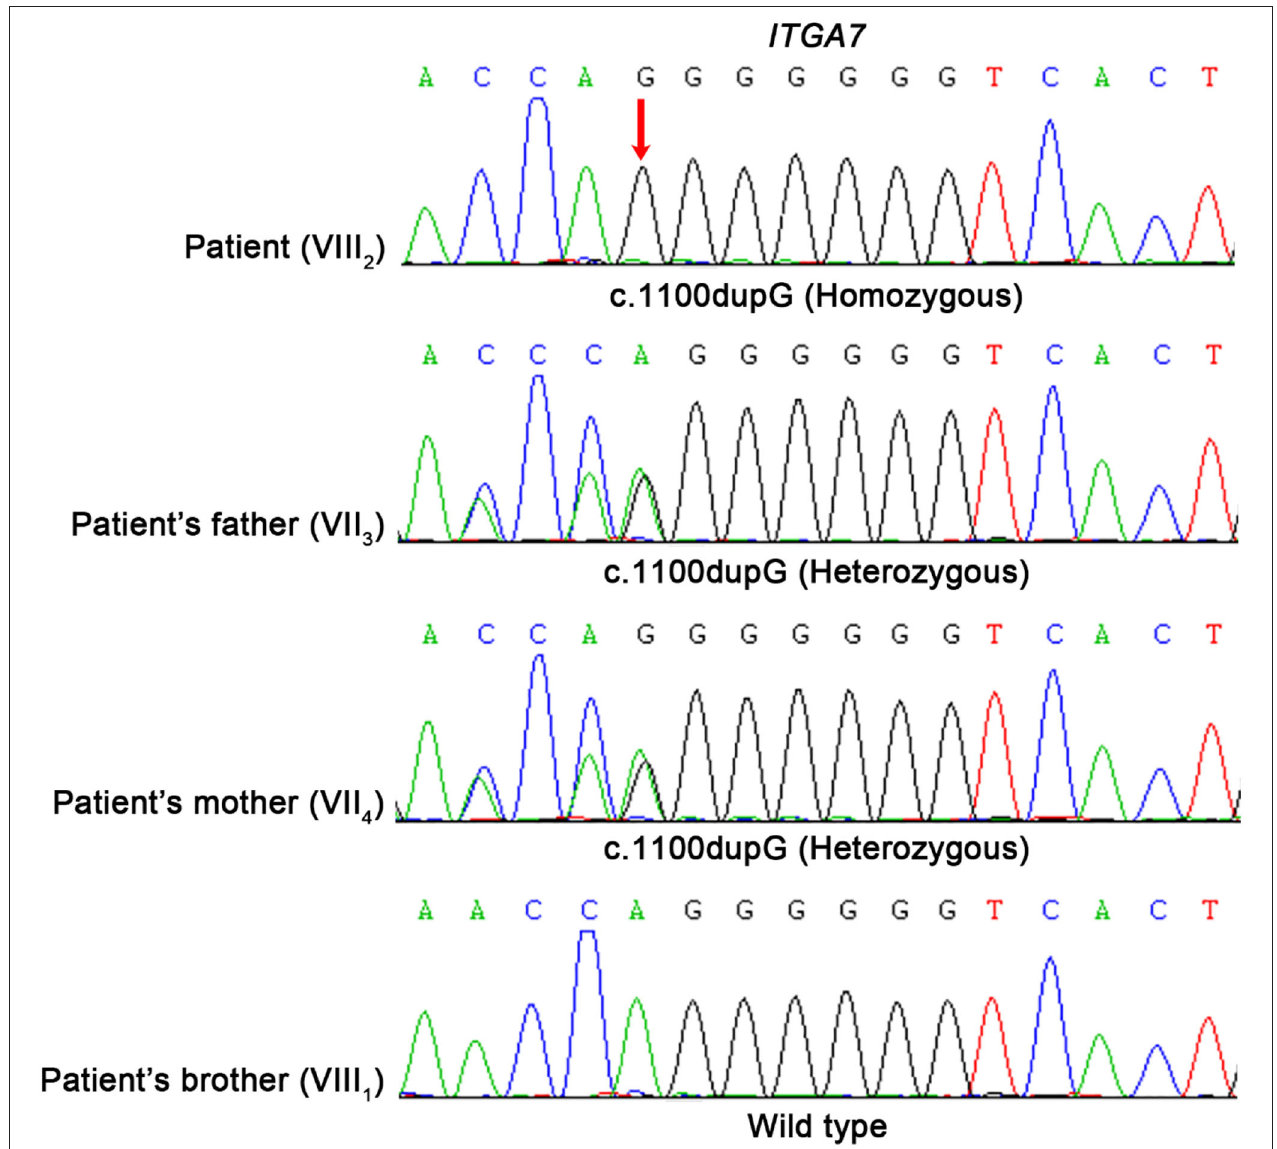
FIGURE 3 | Molecular analysis of ITGA7 gene mutation. Mutation analysis of the ITGA7 gene. Red arrowhead marks the sites of base alterations. The DNA sequences of the family subjects are shown; the pedigree number is indicated on the left.